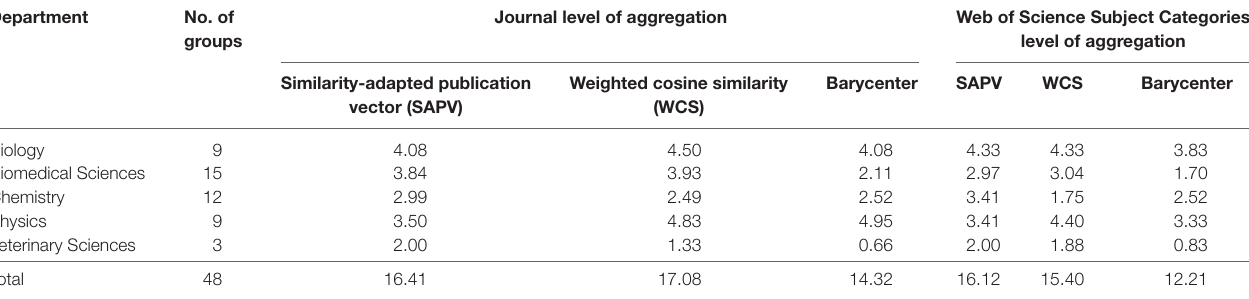
Table 8 | The distribution of total scores for six approaches according to procedure